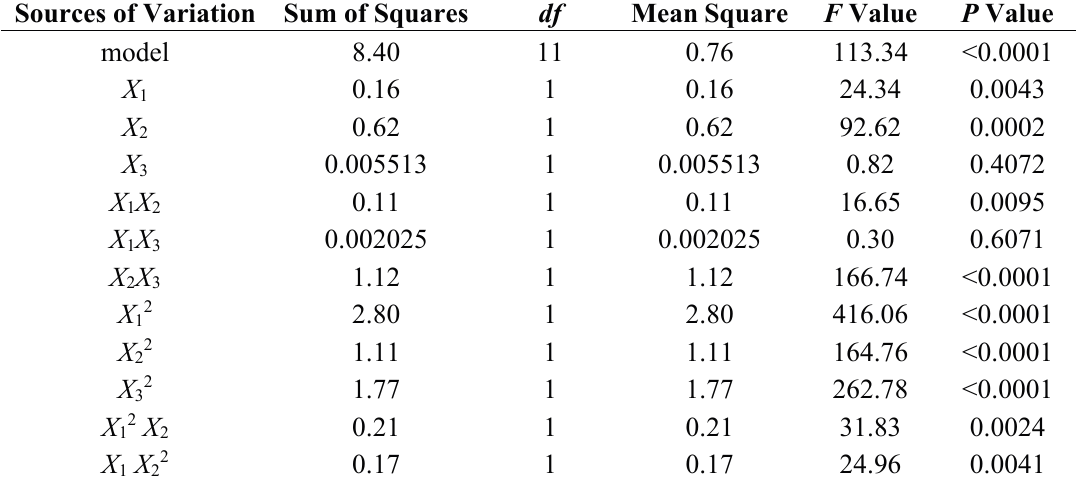
Table 3. Variance analysis of items in regression equation by manual